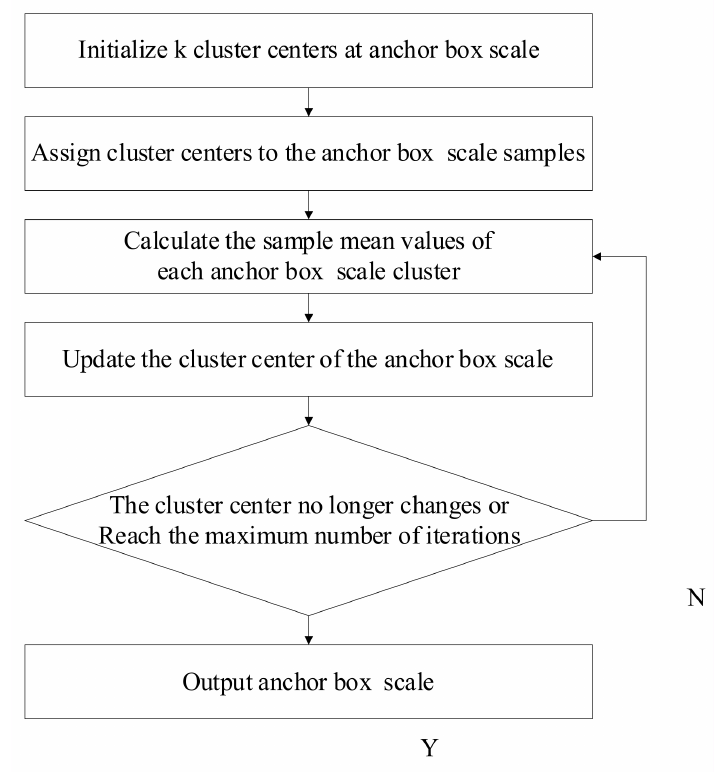
Figure 5. Workflow of the K-Means clustering